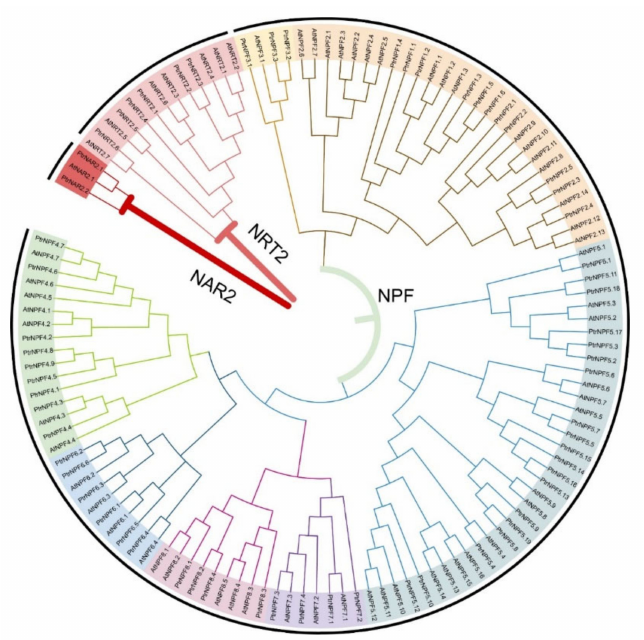
Figure 1. Phylogenetic analysis of NRT members from P. trifoliata and A. thaliana . A total of 64 NRT protein sequences from P. trifoliata (56 NPFs , 6 NRT2s , and 2 NAR2s ) and 61 from A. thaliana (53 NPFs , 7 NRT2s , and 1 NAR2 ) were aligned by ClustalW method. The MEGAX program was applied to construct the phylogenetic tree by the ML method in the default parameters. The whole tree was divided into three parts, NRT1/PTR, NRT2, and NAR2. The modification of the tree was carried out on the iTOL (https://itol.embl.de/, accessed on 1 March